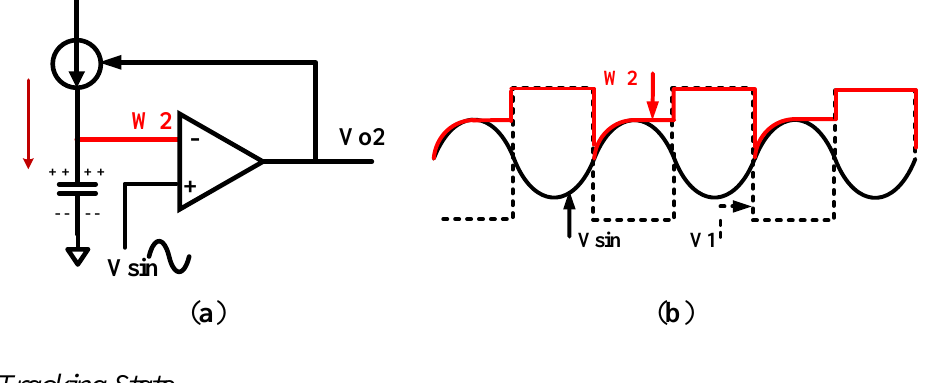
Figure 7. ( a ) Tracking circuit in the crest tracking state. ( b ) When V circuit tries to detect the input